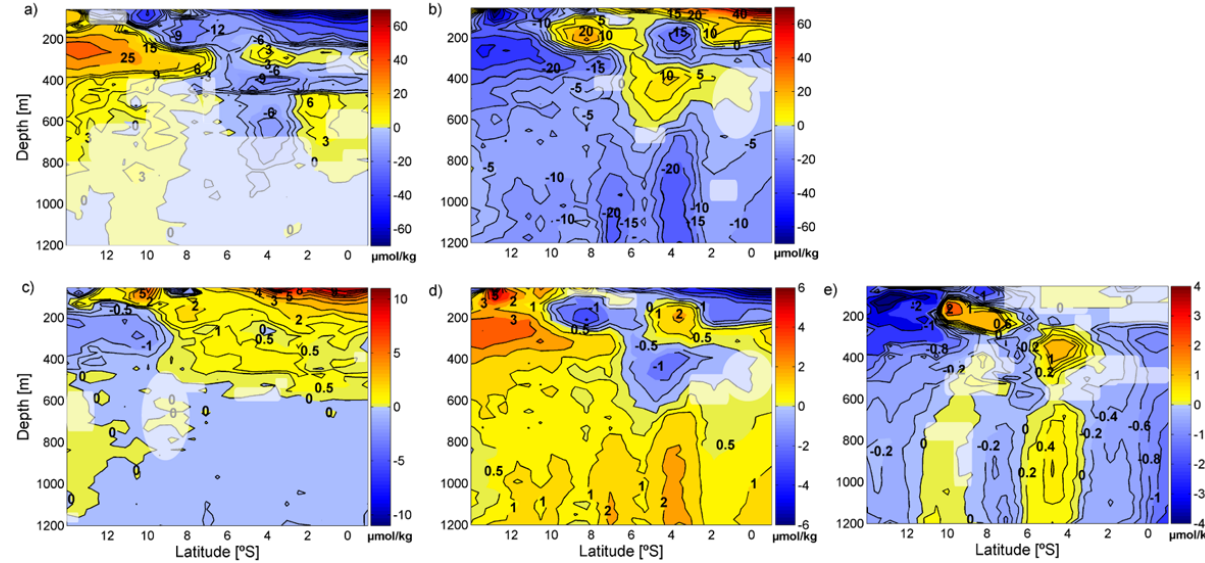
Fig. 10. OMP-derived changes in: (a) physical transport of oxygen (µmolkg − 1 ), (b) oxygen respired (µmolkg − 1 ), (c) physical transport of nitrate (µmolkg − 1 ), (d) remineralized nitrate (µmolkg − 1 ) and (e) denitrified nitrate (µmolkg − 1 ). White shading represents areas where the difference between the measured change and the OMP-modelled change is larger than either component of the change (physical or